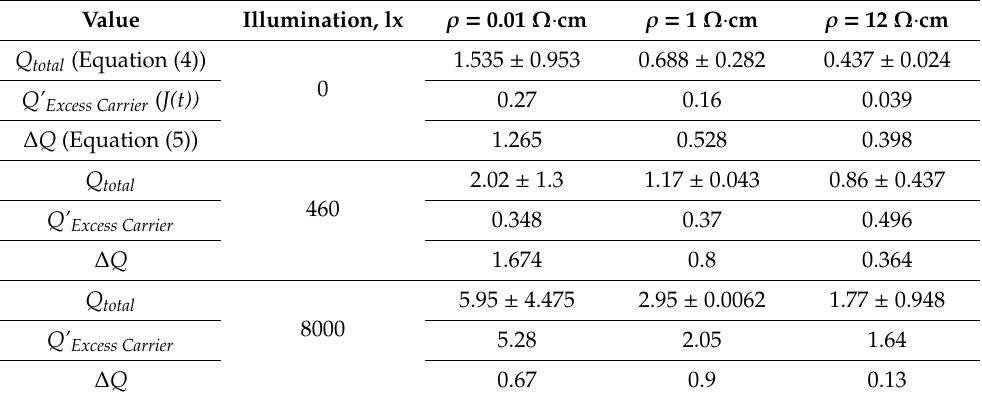
Table 1. Charge values for porous silicon